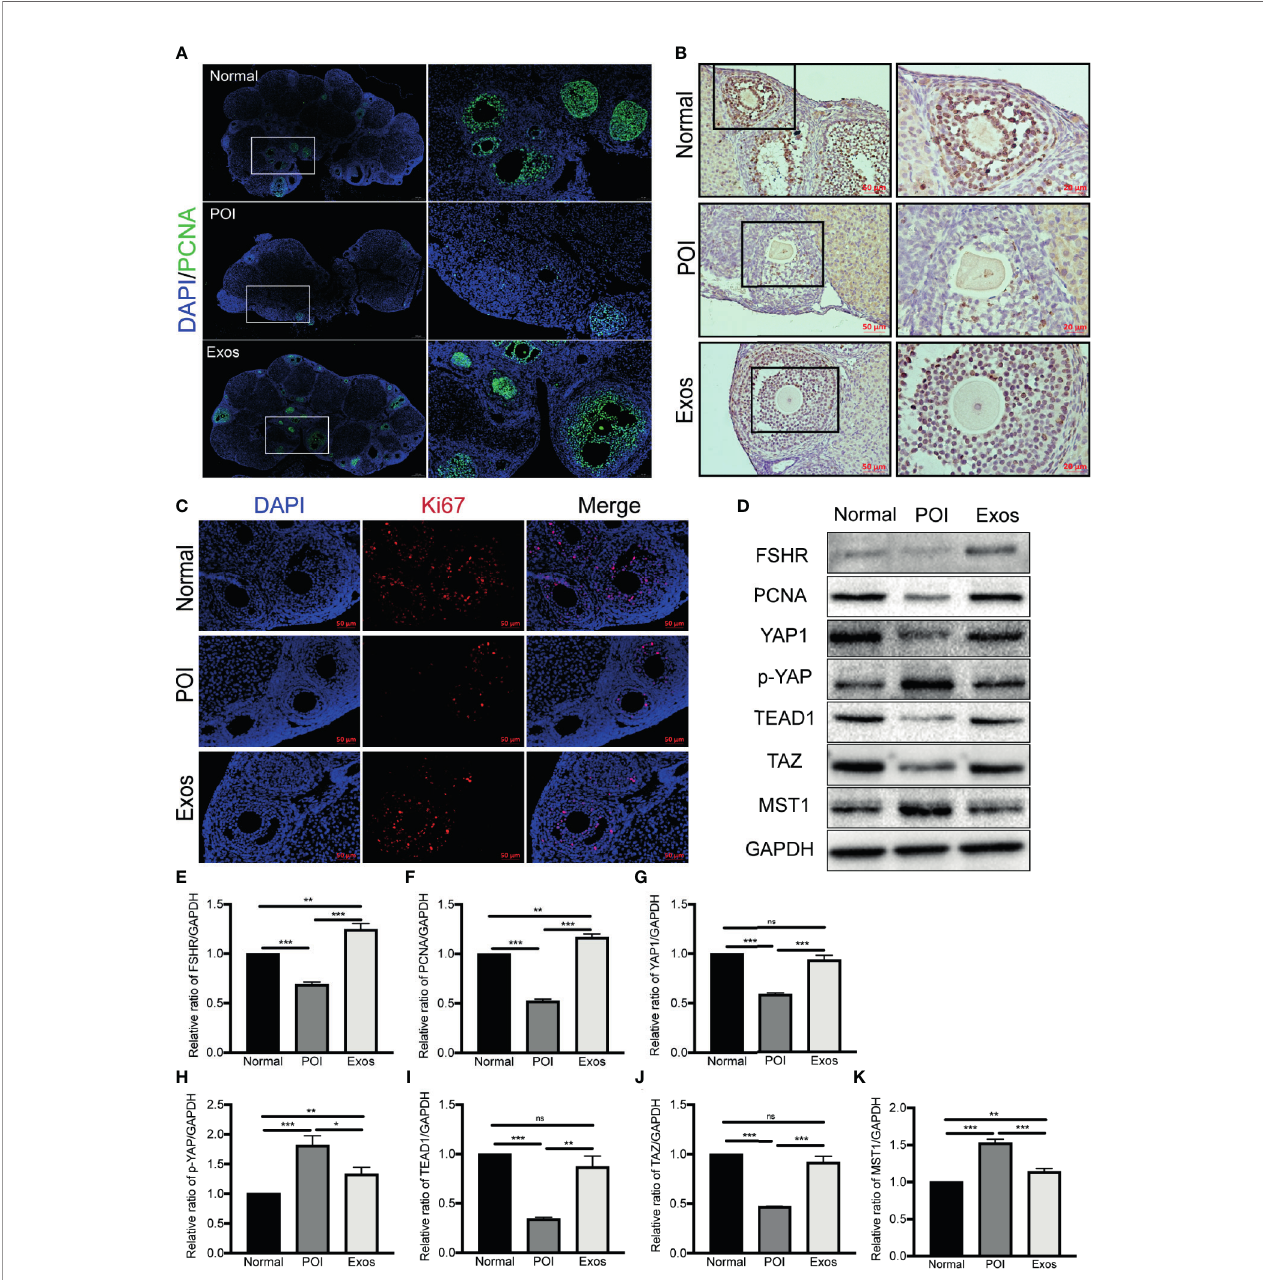
FIGURE 6 | Exosomes promoted ovarian proliferation by regulating the Hippo pathway in POI mice. (A) Expression of PCNA was measured by immuno fl uorescence staining in the different groups. Scale bar: 50 m m and 200 m m. Expression of Ki67 was measured by (B) immunohistochemical staining and (C) immuno fl uorescence staining in the three groups. Scale bar: 20 m m and 50 m m. (D) Representative immunoblots of biomarkers of proliferation and the Hippo pathway, using GAPDH as reference. Quanti fi cation of protein expression revealed that exosomal treatment elevated the expression levels of (E) FSHR, (F) PCNA, (G) YAP1, (I) TEAD1, and (J) TAZ, and suppressed the expression of (H) p-YAP and (K) MST1. Data are presented as mean ± SD. * p < 0.05, ** p < 0.01, *** p < 0.001, ns, no signi fi cance. Data are representative of three independent experiments in each